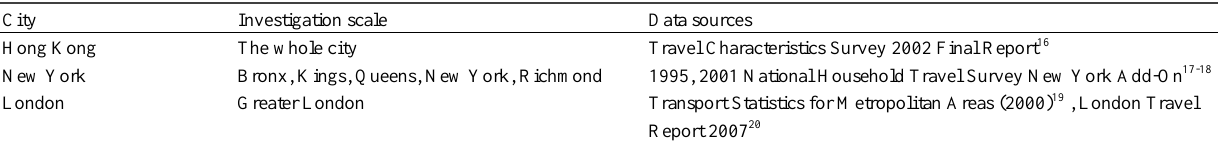
Table 3: Investigation scales and data sources of different